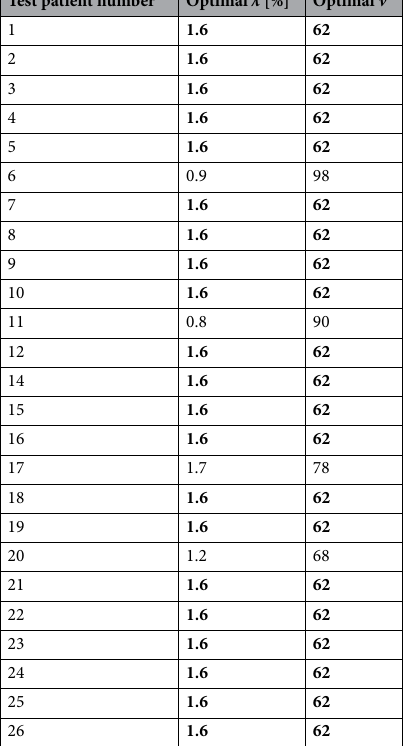
Table 2. Optimal values of λ and ν across patients. The value of the hyperparameters λ and ν that maximized the binary classification accuracy for all patients but the test patient (in the leave one patient out method) is selected by a grid search. Strong stability is observed among the patients in both parameters. The most frequent stable values are shown in